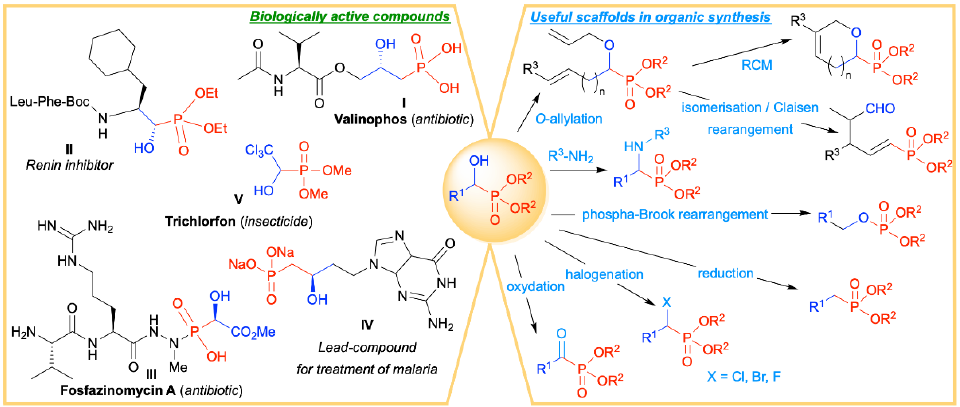
Figure 1. Application of hydroxyphosphonates and phosphonic acids as biologically active com- pounds and useful scaffolds in organic synthesis-selected examples.